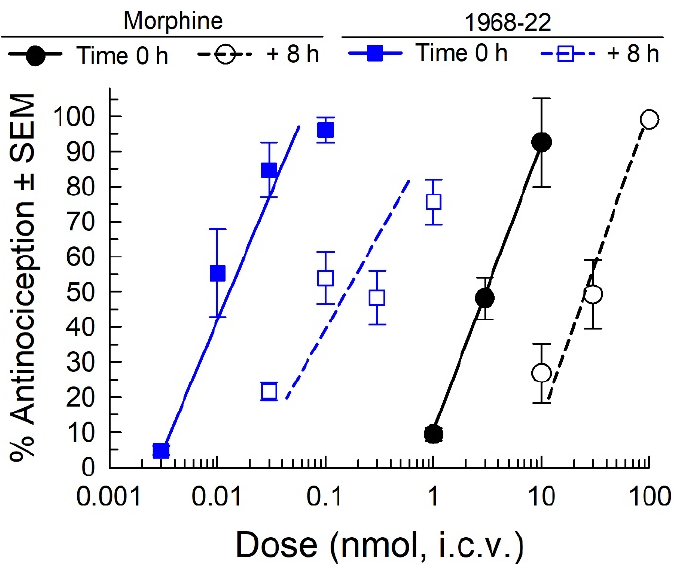
Figure 6. Assessment of potential acute antinociceptive tolerance in the 55 ◦ C warm-water tail-withdrawal assay following i.c.v. administration of morphine (circles) or 1968-22 (squares). Points report antinociception at peak response in naïve mice (Time 0 h) and mice that were previously administered an ED 50 dose of test compound (as listed) prior to additional administration of a dose of test compound eight hours later (Time 8 h). Points represent average % antinociception ± SEM from 8 to 12 mice for each set presented.